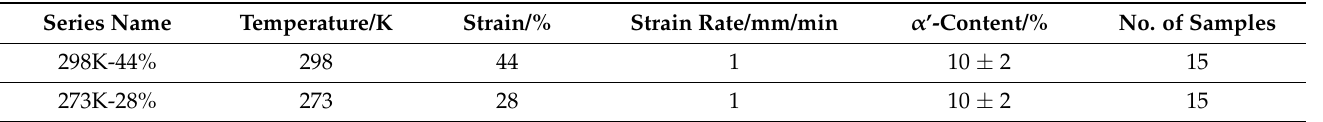
Table 4. Designation of specimen series, ambient temperature during pre-deformation, strain, strain rate, and number of specimens used to characterize fatigue strength.